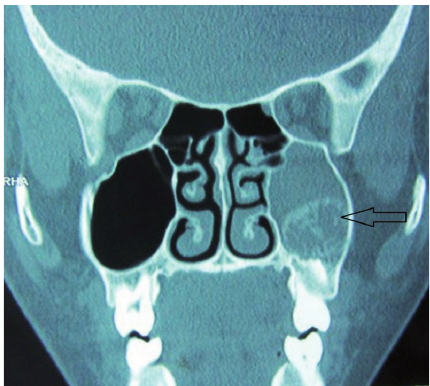
Figure 3: Coronal CT scan section showing the lesion completely obliterating the left maxillary